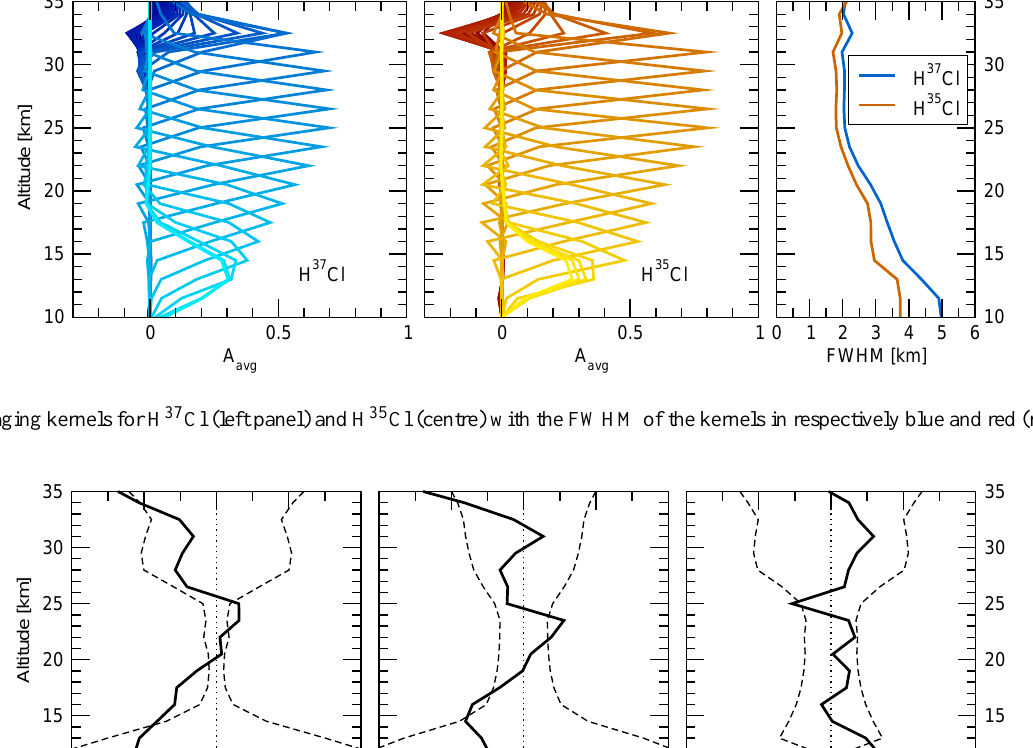
Fig. 6. The individual estimates of systematic effects in the HCl profiles based on the H 37 Cl line (left panel) and the H 35 Cl line (right panel). Several systematic error sources have been grouped together. In black the spectroscopic error is given for uncertainties in the spectral widths and line strengths of the HCl lines. In red the errors of various instrumental uncertainties are shown; the solid red line combines the errors due to uncertainties in field of view, local oscillator frequency, instrumental line shape, and sideband ratio, the dotted red line refers to the absolute pointing, and the dashed red line to the non-linearity of the detector response function. In blue the systematic error due to the radiometric calibration is given and in turquoise the systematic error by uncertainties in the atmospheric condition (temperature and pressure profiles). The thick black line is the RSS of these errors. 23